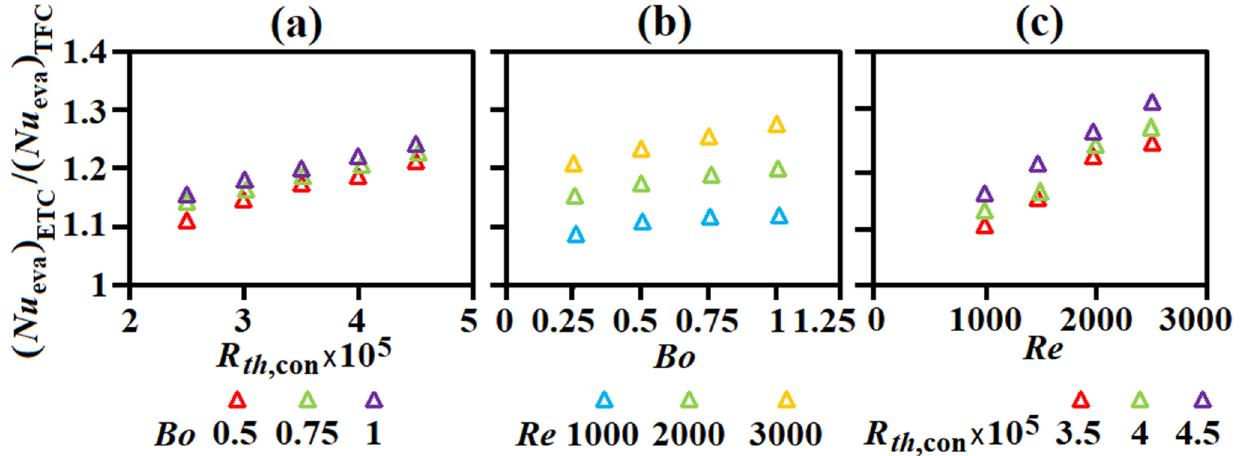
Figure 5. The ratio of Nu eva between the loops with ETC and TFC against ( a ) Re , ( b ) Bo , ( c ) R th ,con